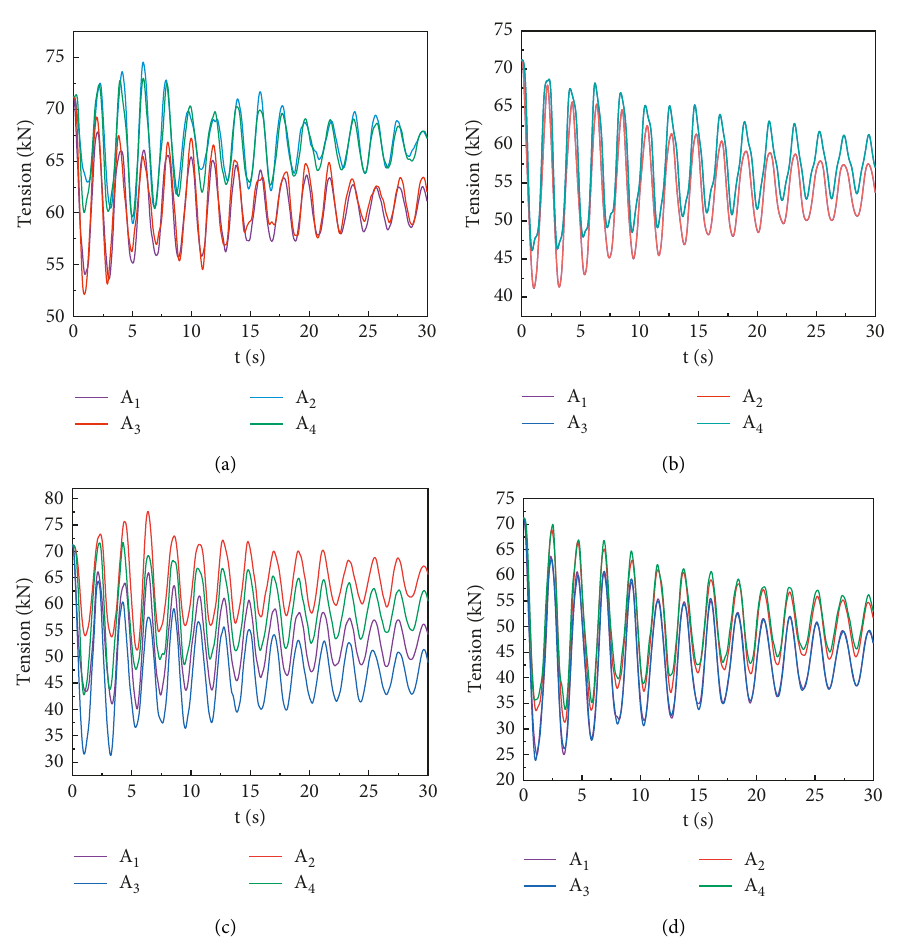
Figure 7: Tension-time curve of conductor hanging point: (a) working condition, (b) working condition, (c) working condition, (d) working condition (asynchronous ice